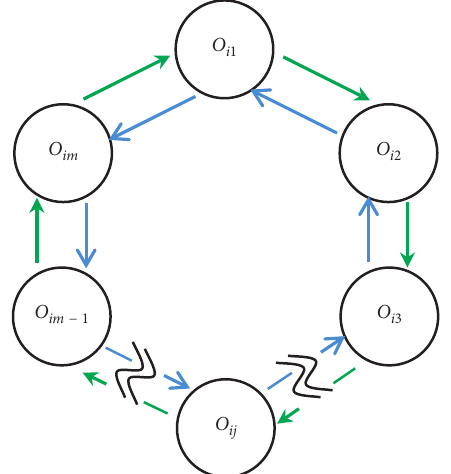
Figure 1: A diagram of the operation-precedence-relation chain of the job J i in